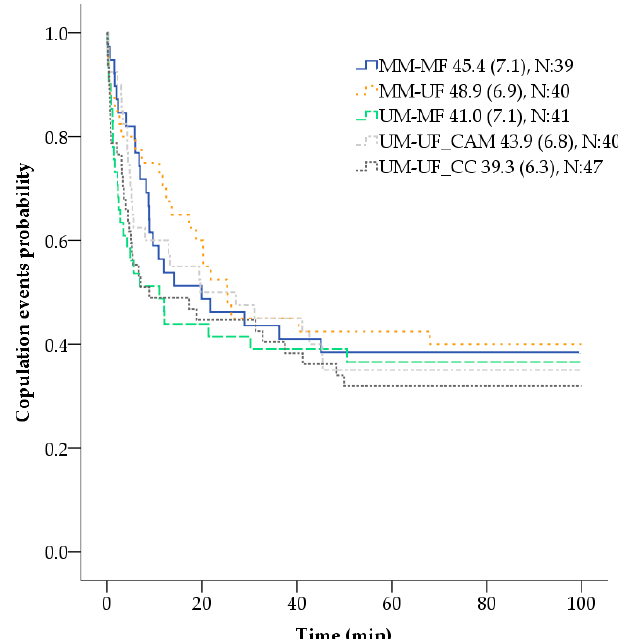
Figure 1. Coupling time (min) or length of time until the occurrence of copulation events after each female was introduced to the male of different cross-combinations. Numbers following the cross-combinations indicate mean (±SE) coupling time (min), and the total number of females sampled (N) per combination. Unmarked female (UF) marked female (MF), unmarked male (UM), marked male (MM), control colony (CC), and control application method-sham (CAM).